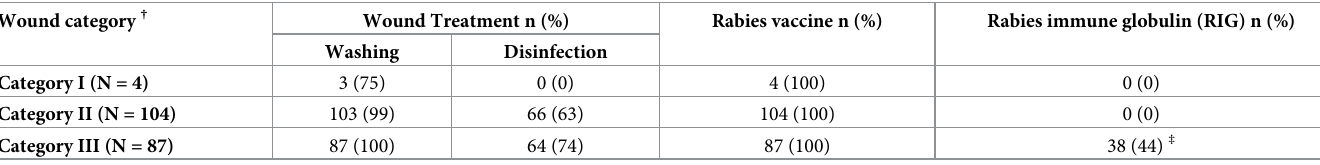
Table 4. Comparison of rabies post-exposure prophylaxis (PEP) recommended by national guidelines with actual rabies PEP received by 195 patients � at five selected clinics in county A, Hunan Province, China, July-August